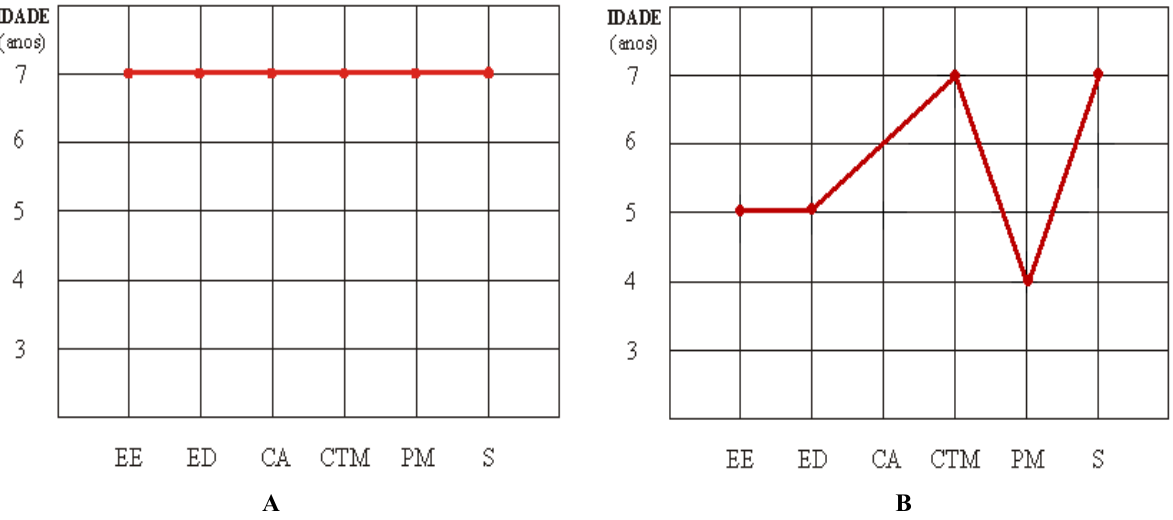
Figura 1 . Perfil neurológico de desenvolvimento elaborado a partir da idade de execução das diferentes provas do ENE. Nota . Em A, desempenho adequado para sete anos de idade; em B, desempenho alterado, pois a criança de sete anos de idade conseguiu executar adequadamente apenas as provas de Coordenação Tronco-membros (CTM) e de Atividade Sensitiva e Senso- rial